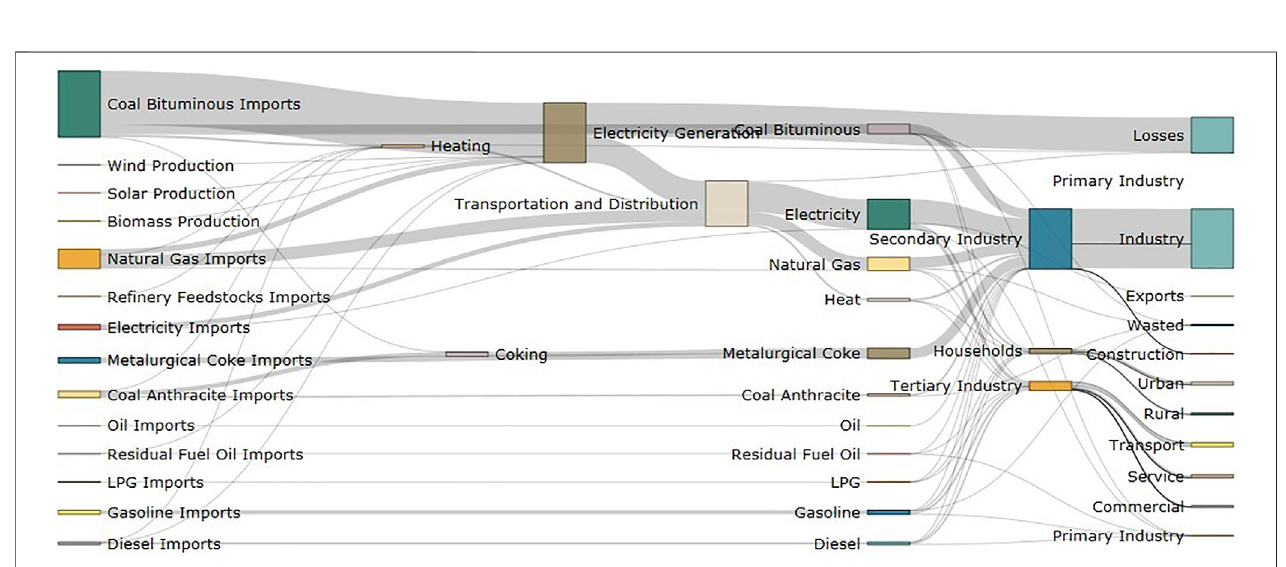
FIGURE 6 | Energy consumption in the different scenarios during the process of processing and conversion.